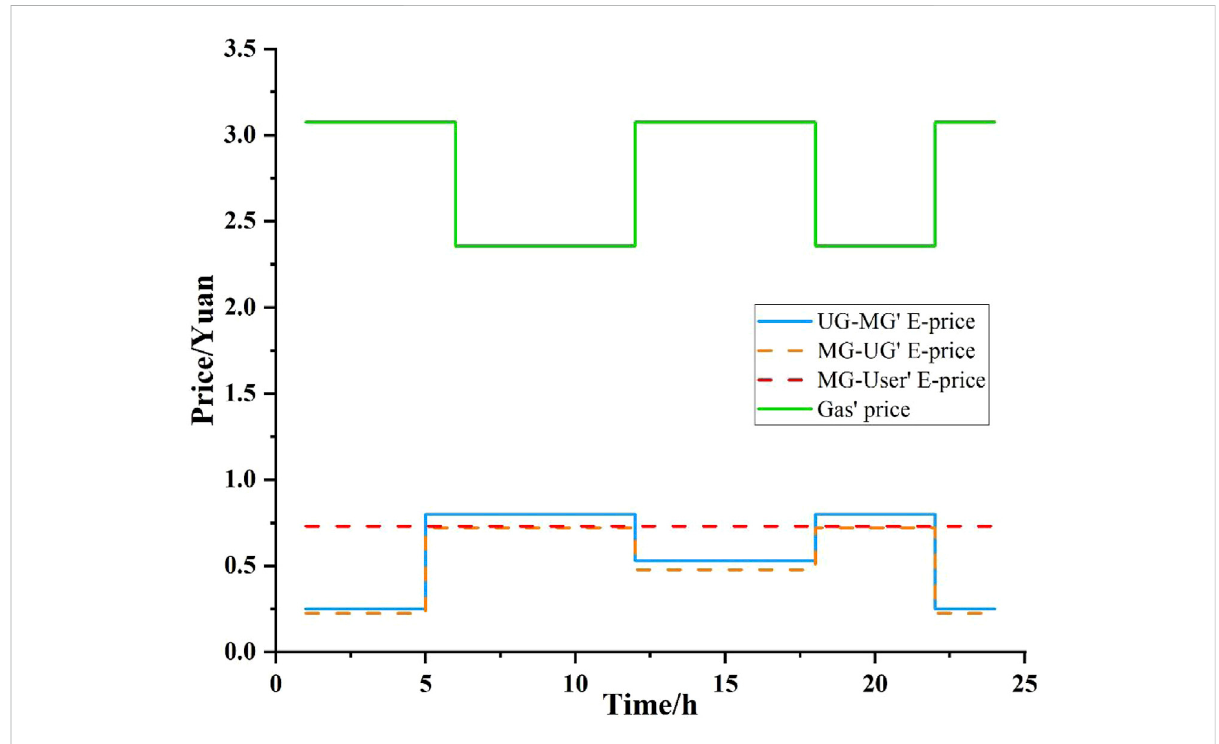
FIGURE 5 Energy trading price curve.